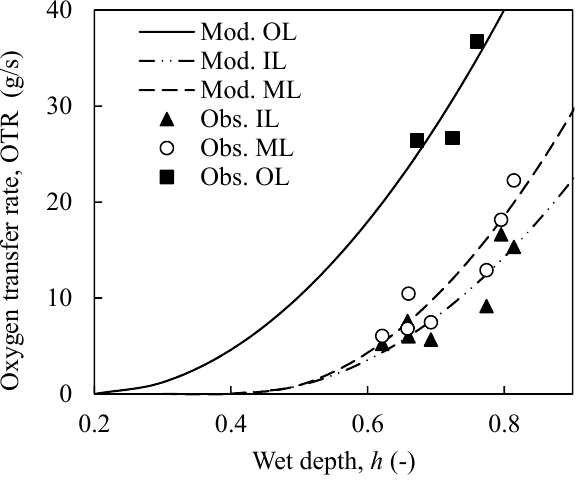
Figure 5. The relationship between the OTR and wet depth of rotating disks. Dots are acquired by observation, and lines are modeling calculation. Mod and Obs refer to modeling and observation, respectively. IL, ML, and OL are abbreviations of inner, middle and outer lanes, respectively. The zero point of OTR curves in horizontal coordinate axis indicates the scenario that only